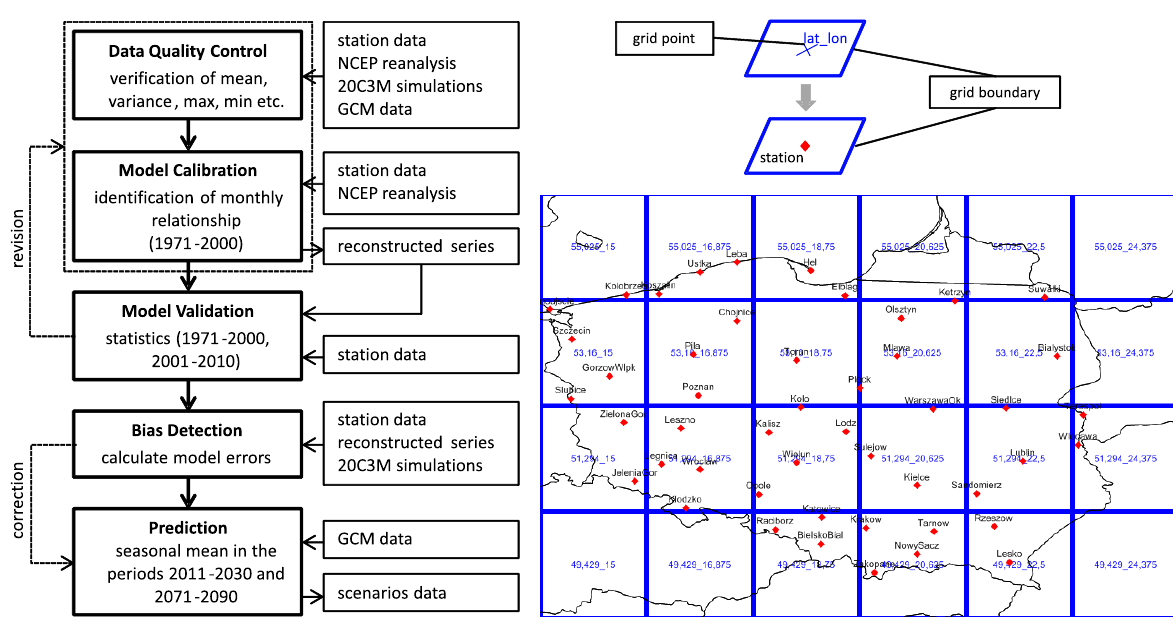
Fig. 3. Main stages in WG method. Left panel contains bolded boxes which represent main steps of the method. Data Quality Control was performed to verify basic statistics, outliers etc. Model Calibration phase identify connections between predictor and predictand. Model Validation check reliability of the model (with revision – back step if not reliable). Bias Detection based on reconstruction and original data was calculated to correct scenarios in XXI century. The final step Prediction concerns estimating seasonal means for two periods in XXI century. Horizontal vectors represent input/ output data from/to right-side boxes. Right panel shows predictors large-scale domain with grid boxes (blue square) and predictand small- scale field represented by measurement stations (red